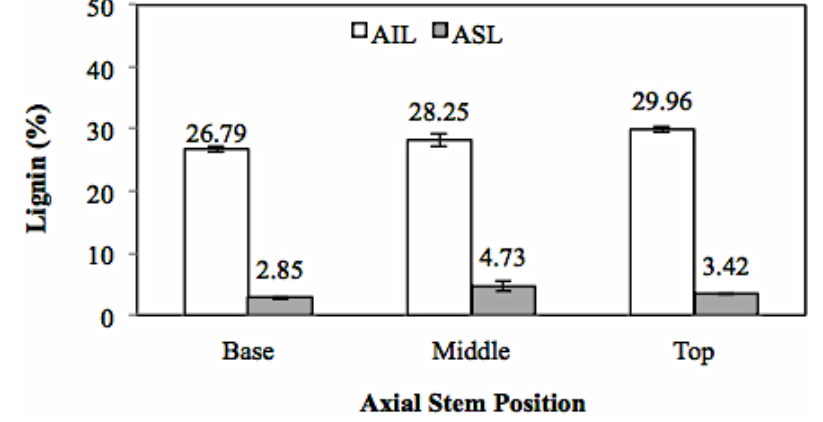
Figure 7. Lignin contents of Gigantochloa pruriens .